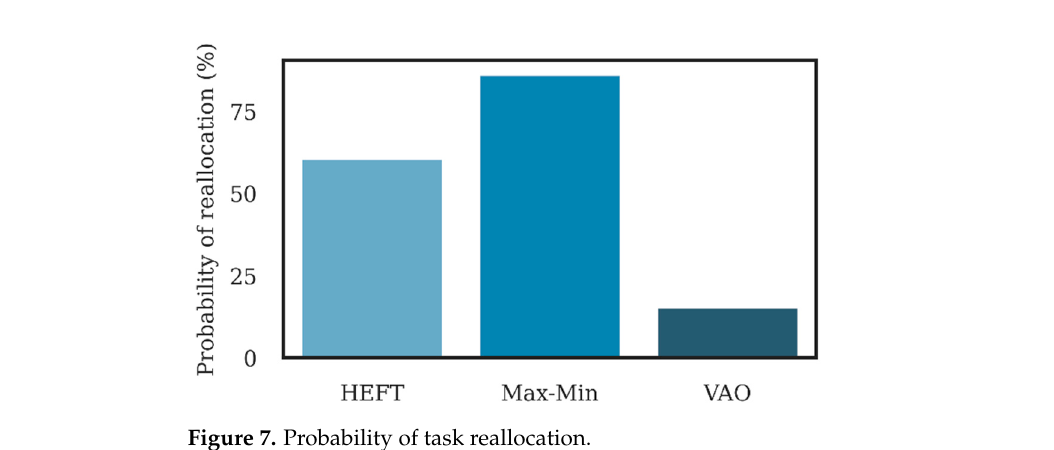
Figure 7. Probability of task reallocation.